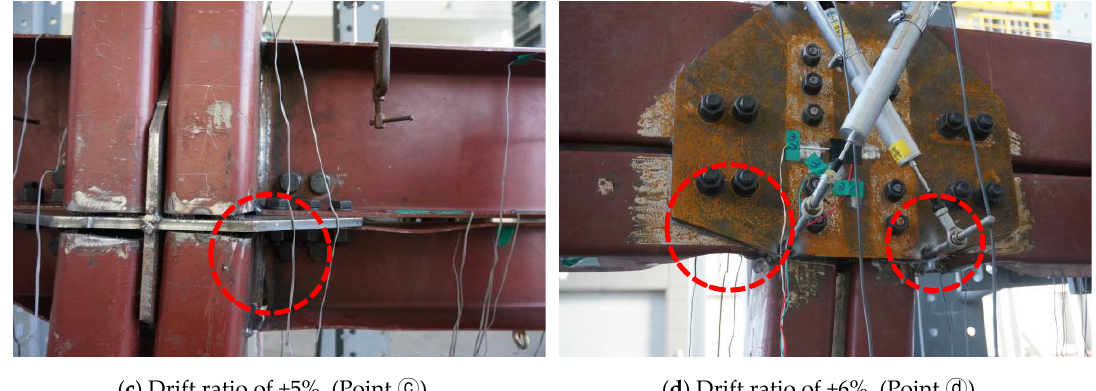
Figure 12. Failure sequence of Specimen IC_OB_F.